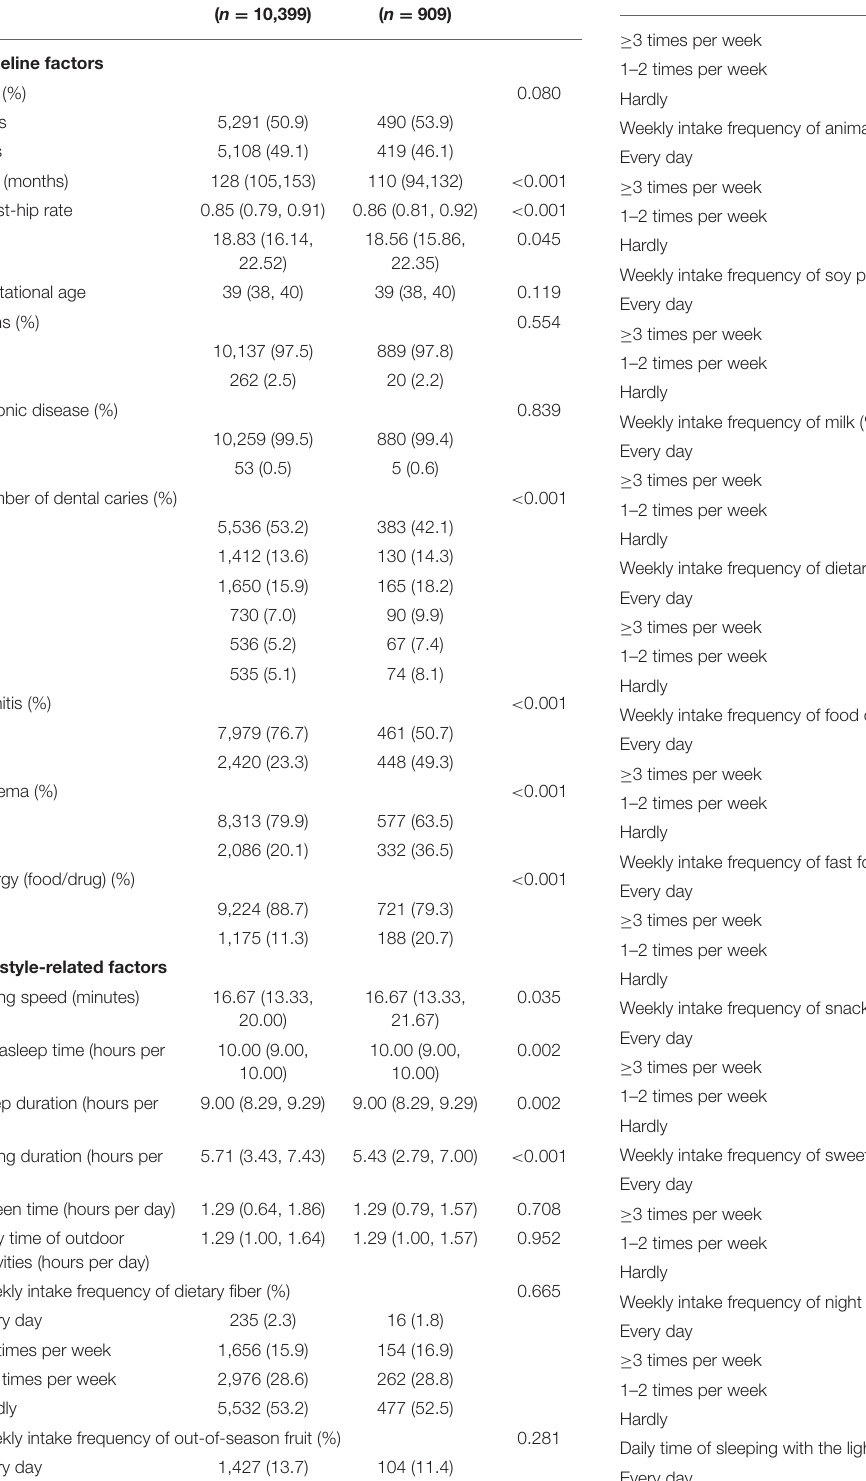
TABLE 1 | The baseline characteristics of participating students according to lower respiratory tract infection. Factors under